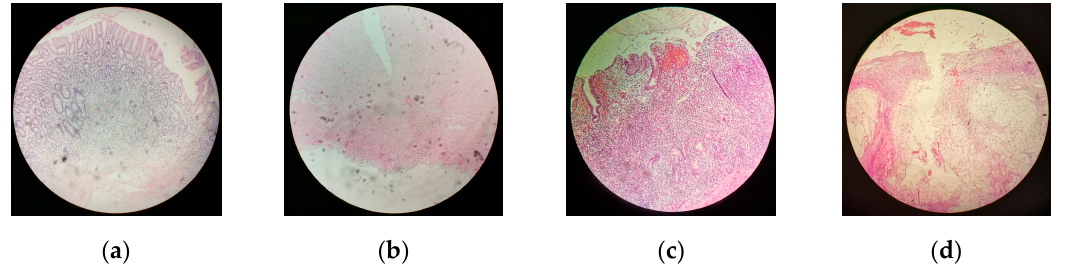
Figure 1. H & E-stained histopatolgy of gastric ( a ) mucosa; ( b ) serosa; ( c ) cancer localazed in mucosa; and ( d ) cancer invasion in serosa.